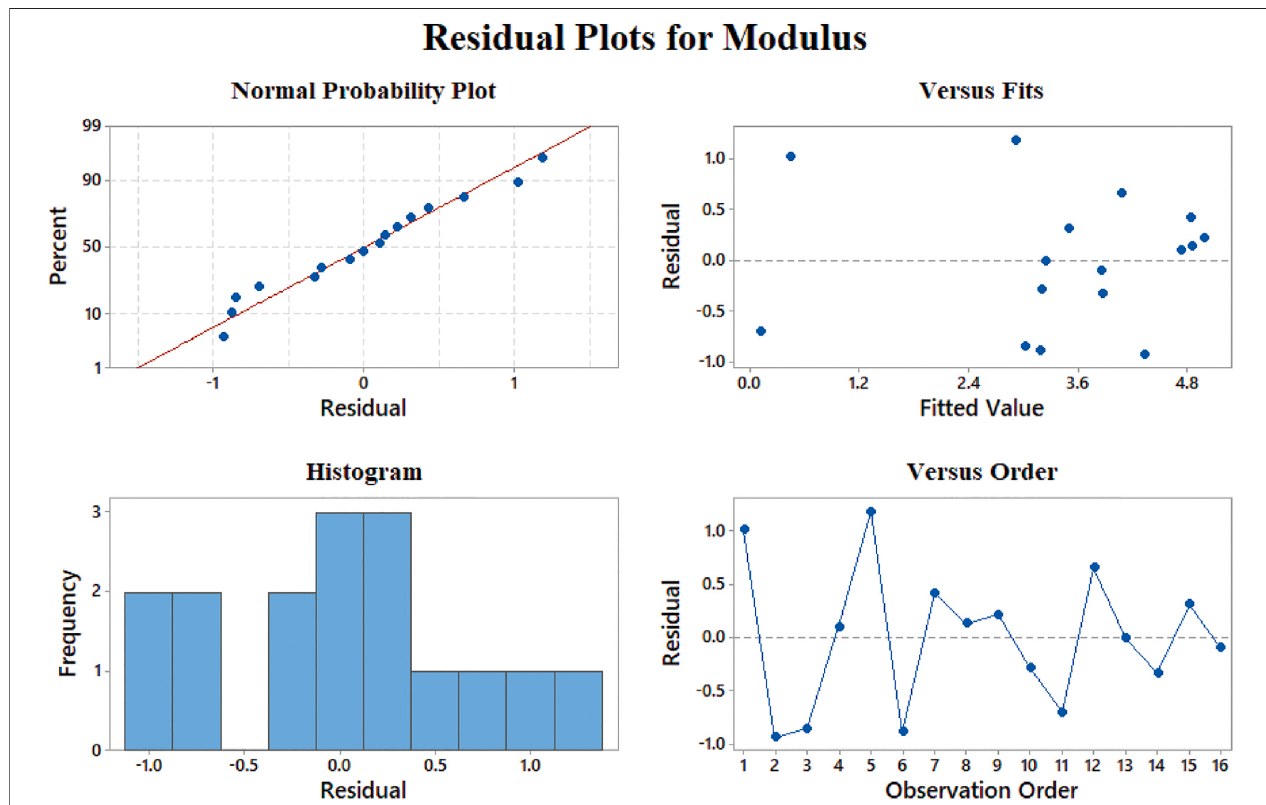
FIGURE 8 | Representing errors of the elastic modulus model: (A) normal probability, (B) versus fi t, (C) histogram, and (D) versus order.